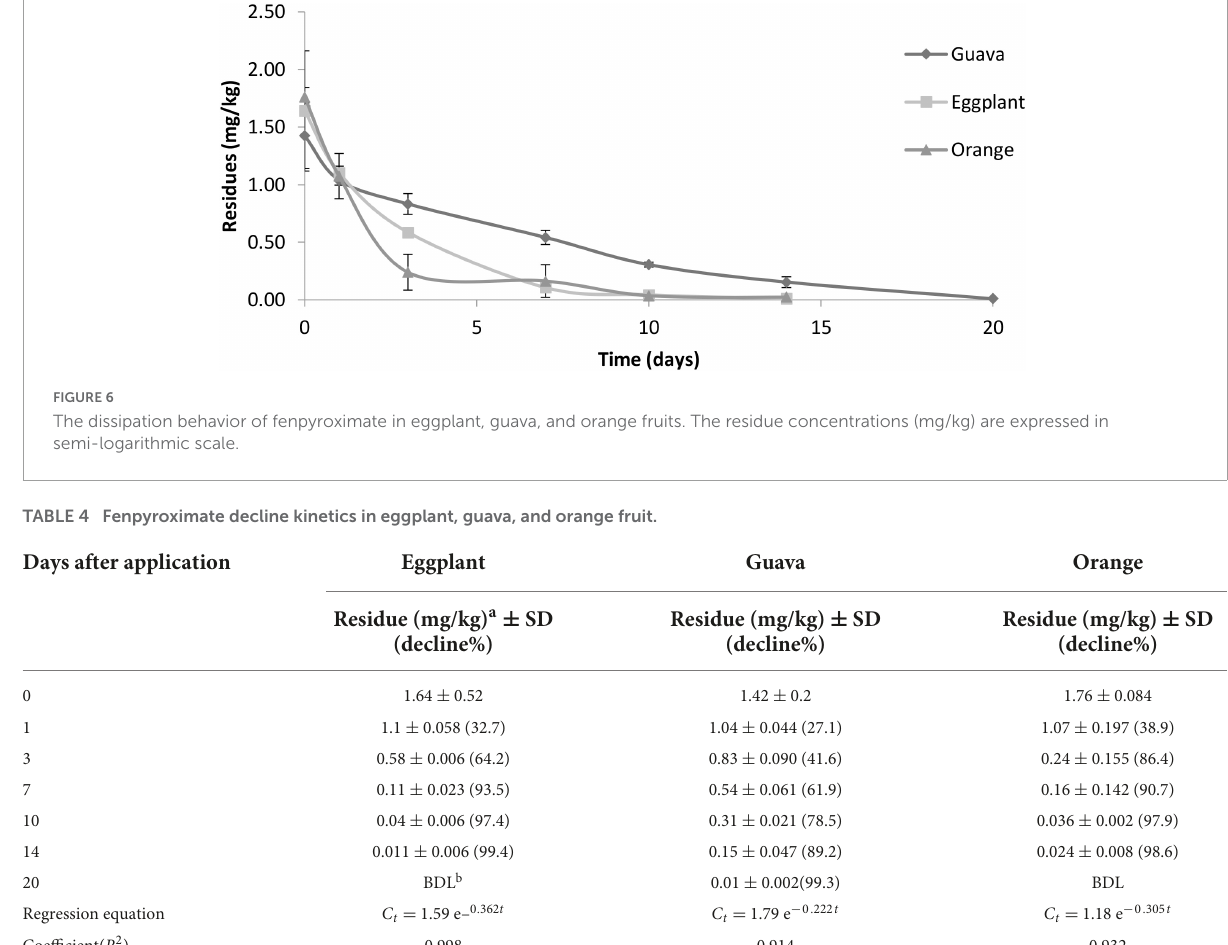
a Averageofthreereplicates. b